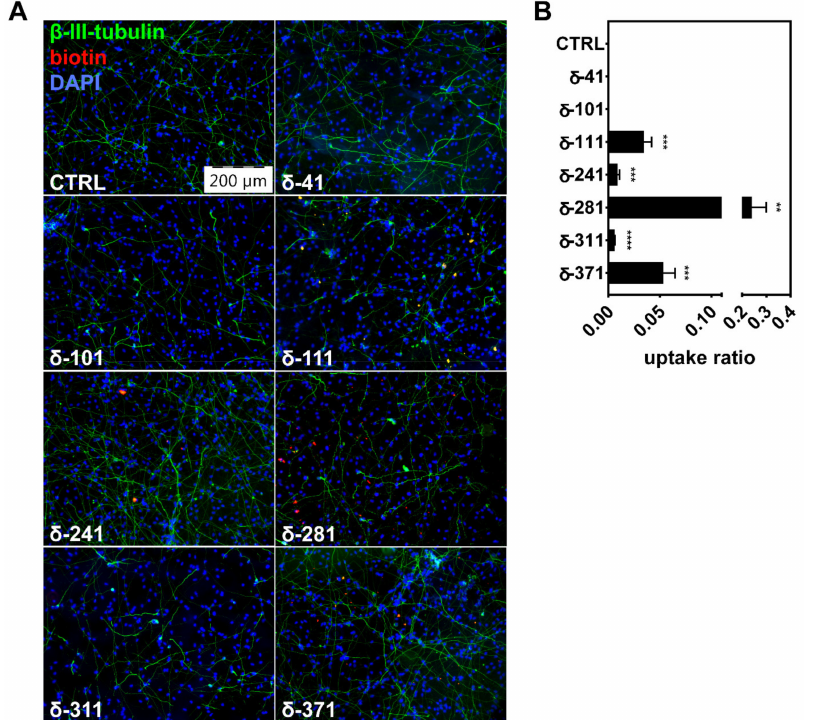
Figure 4. CK1 δ -derived peptides are able to enter living cells. ( A ) Differentiated naïve hNPCs were treated with 1 µ M of the indicated biotinylated CK1 δ -derived peptides for 24 h. Cells were fixed and stained with DAPI (blue, nuclei), anti- β -III-tubulin (green, neuronal microtubule network), and streptavidin-TRITC (red, biotinylated peptides). Images were taken at 10 × magnification using an epifluorescence microscope (Olympus IX81). Scale bar: 200 µ m. ( B ) Quantification of peptide uptake was done by cell counting and calculated as the number of detected peptide accumulations per cell ( n = 3). Statistical analysis was performed using one-tailed t -test shown as ** for p ≤ 0.01, *** for p ≤ 0.001, or **** for p ≤